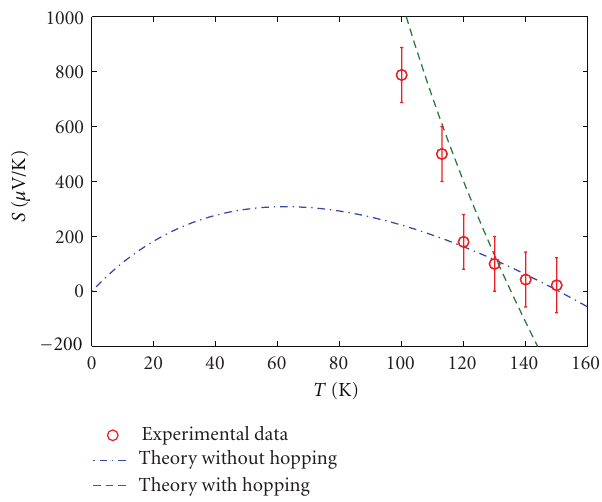
Figure 3: Thermopower for the Ga 0 . 95 Mn 0 . 05 As nanowire device as function of temperature. The experimental data matches well at high temperature with values calculated using a model without hopping [21]. However, at temperatures below 120 K, the nanowire thermopower starts to rise far above the extrapolation. Addition of a hopping term qualitatively accounts for the rise in